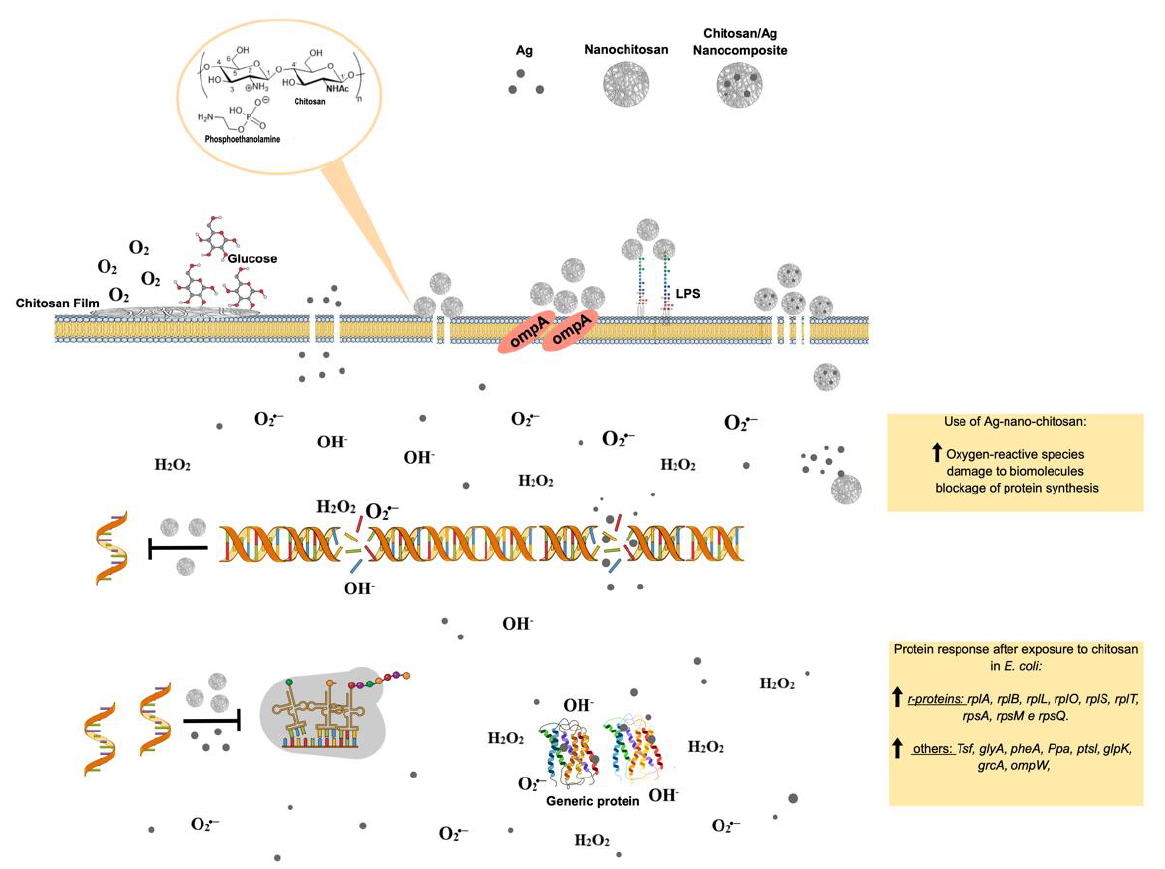
Figure 6. Molecular effects of chitosan nanoparticles on E. coli growth inactivation. Chitosan seems to interact with phospholipids, particularly phosphatidylethanolamine (PE), the most abundant phospholipid in E. coli , triggering the impermeabilization or disassembly of its outer membrane. The impermebialization of bacteria membrane by the nano-chitosan films inhibit glucose and O 2 uptake, causing bacteria death. After exposure to nano-chitosan particles, E. coli experiences a differential expression of proteins involved in protein biosynthesis machinery and amino acid and purine nucleotide supply, as already demonstrated [38] and shown in the yellow rectangle at the lower right corner. When E. coli is exposed to Ag-nano-chitosans, an increase in reactive oxygen species is observed, followed by consequent damage to cellular structures, including proteins and nucleic acids. Chitosan and Ag nanoparticles, as well as cellular structures, are not represented in their real scale. This figure was drawn using the infographic maker Mind the Graph, available at https://mindthegraph.com.